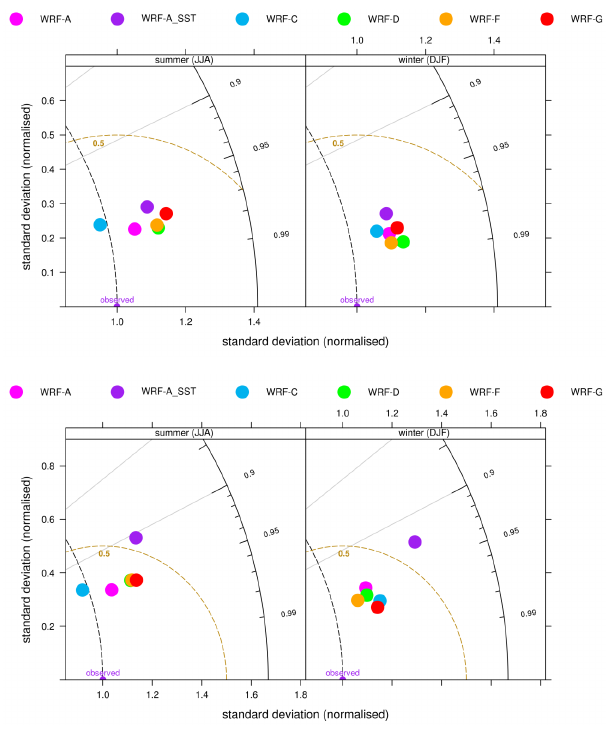
Figure 2 Temporal (upper panel) and spatial (bottom panel) Taylor plots for surface 3 Figure 2. Temporal (upper panel) and spatial (bottom panel) Taylor temperature averaged over Europe for summer and winter 1990-2008. Upldated plot 4 plots for surface temperature averaged over Europe for summer and winter 1990–2008. Updated